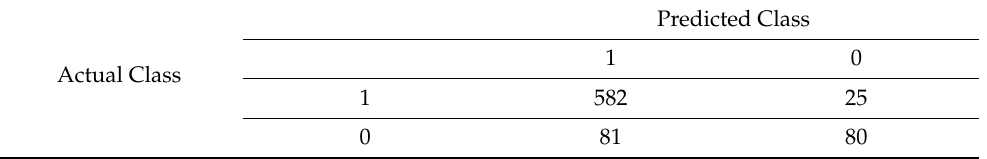
Table 9. Confusion matrix of DCNN.